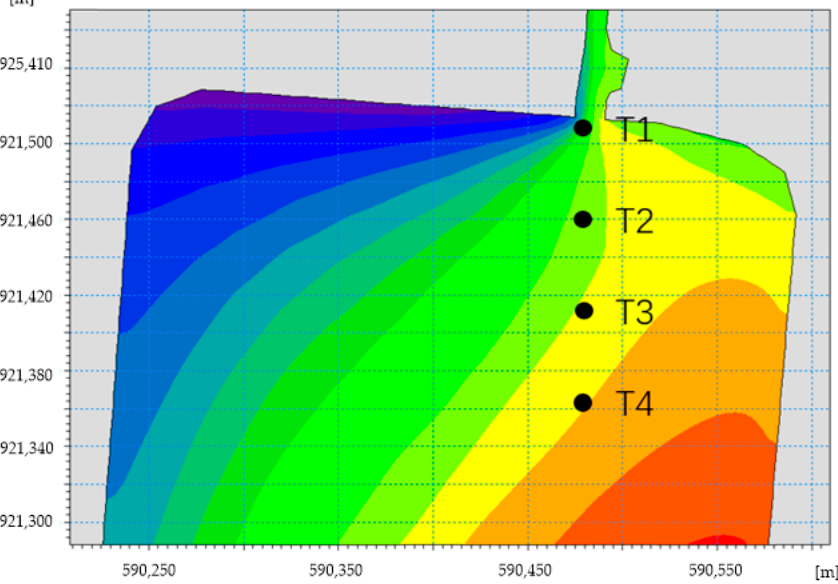
Figure 5. Marking location of characteristic points, the coordinate range is (590,210, 3,921,290)~(590,610, 3,921,560). T1, T2, T3, and T4 are the four characteristic points selected at the outlet of the sedimentation basin.